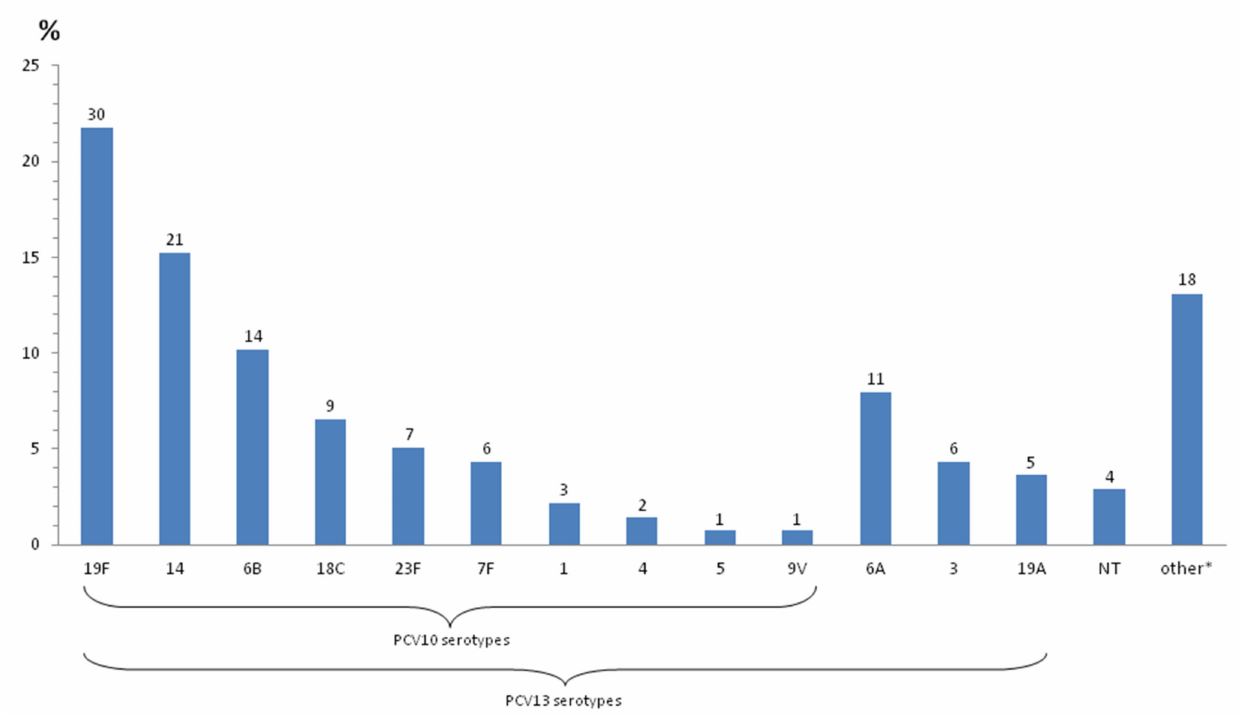
Figure 1. Serotype distribution of invasive pneumococcal isolates. Serotype distributions of invasive pneumococcal isolates are presented by a declining frequency of PCV10 serotypes and PCV13 serotypes (numbers of isolates for each serotype are presented above the bars). Other serotypes (*) refer to serotypes 23A (N = 3), 33F (N = 3), 9A (N = 2), 10A (N = 2), 9N (N = 1), 11A (N = 1), 12F (N = 1), 15B (N = 1), 15C (N = 1), 15F (N = 1), 17F (N = 1), and 22F (N =